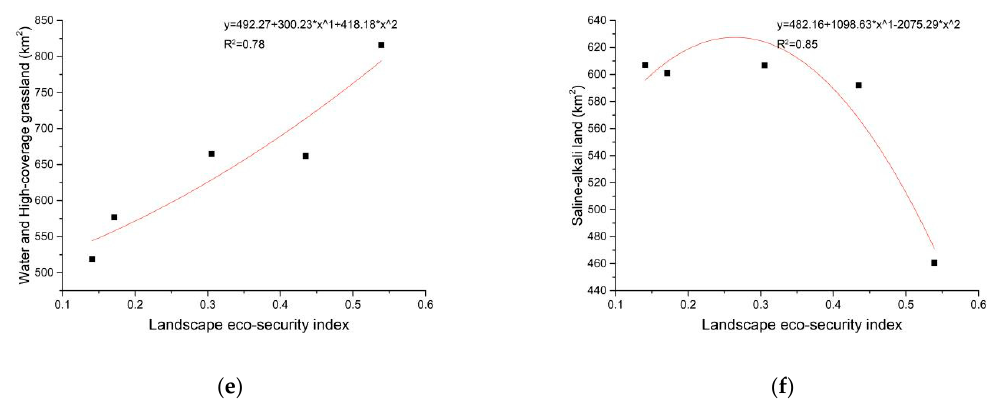
Figure 15. The relationship between landscape eco-security index and the indicators: ( a ) GDP indicators; ( b ) oil production indictors; ( c ) protection investment indicators; ( d ) landscape patches indicators; ( e ) water and high coverage grassland area indicators; ( f ) saline-alkali land area indicators.